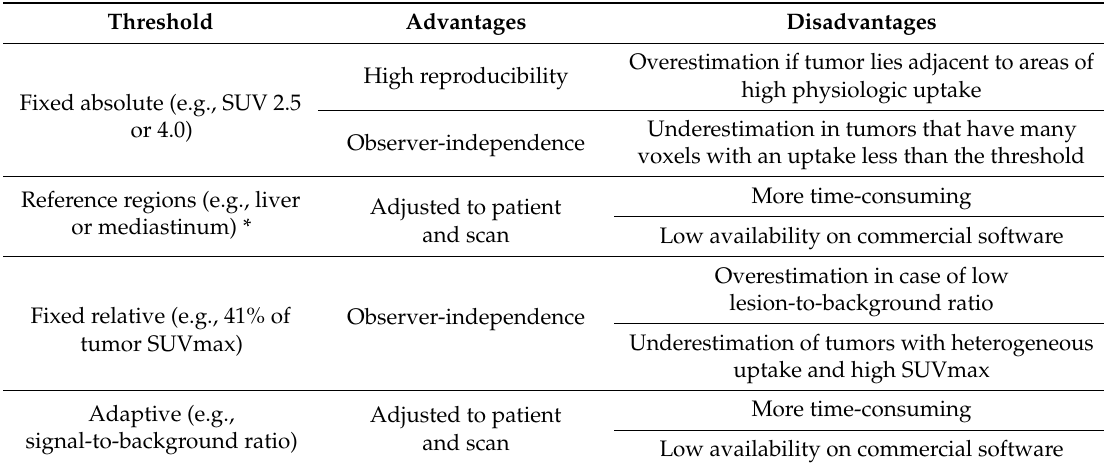
Figure 2. Metabolic tumor volume (MTV) measurement in a patient with advanced-stage Hodgkin lymphoma based on di ff erent thresholding methods. SUV, standardized uptake value; SUV max , maximum SUV; SUV mean , mean SUV. Table 2. Common approaches for MTV calculation with their main